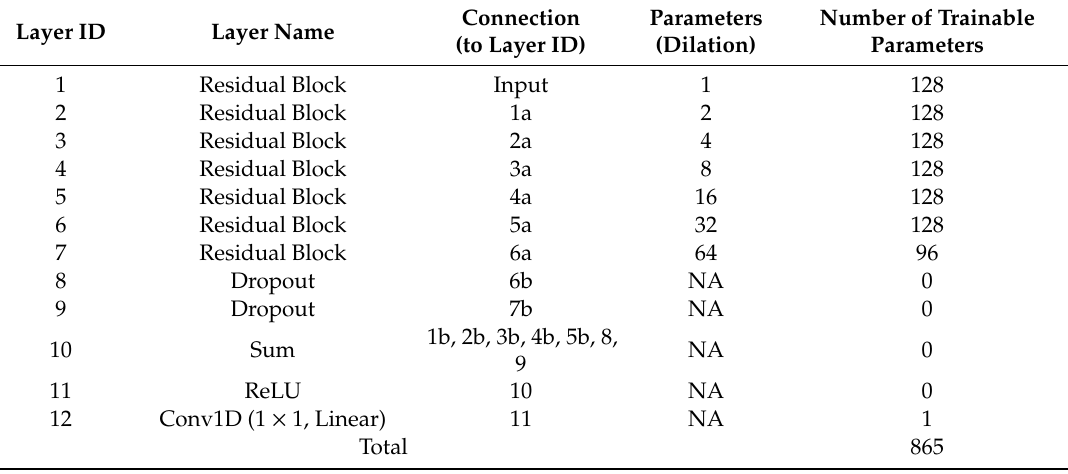
Table 4. SeriesNet hyperparameters.